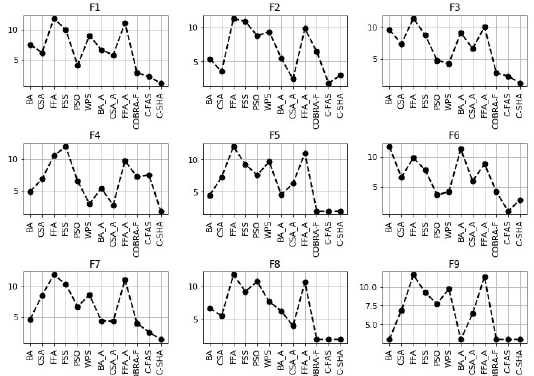
Figure 7. Results of the Friedman statistical test for SET-2 ( D =